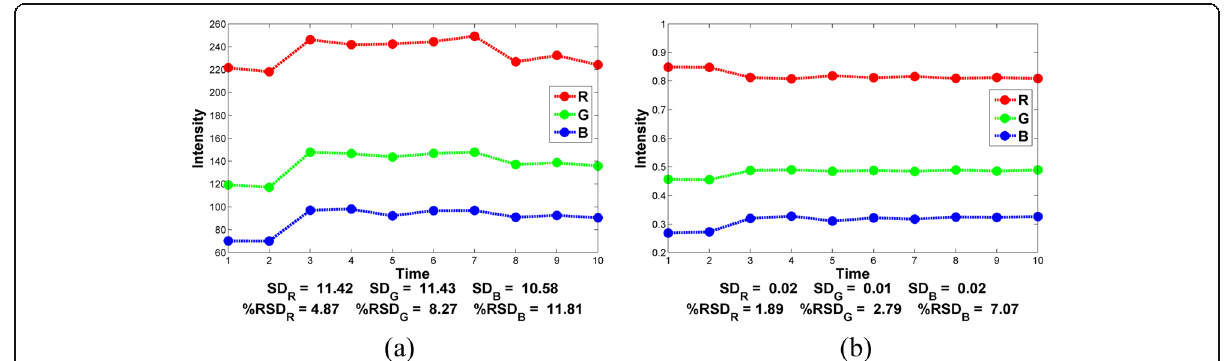
Fig. 6 RGB intensity recorded from the pH test strips using experimental scanner for 10 consecutive hours a without using data preprocessing and b